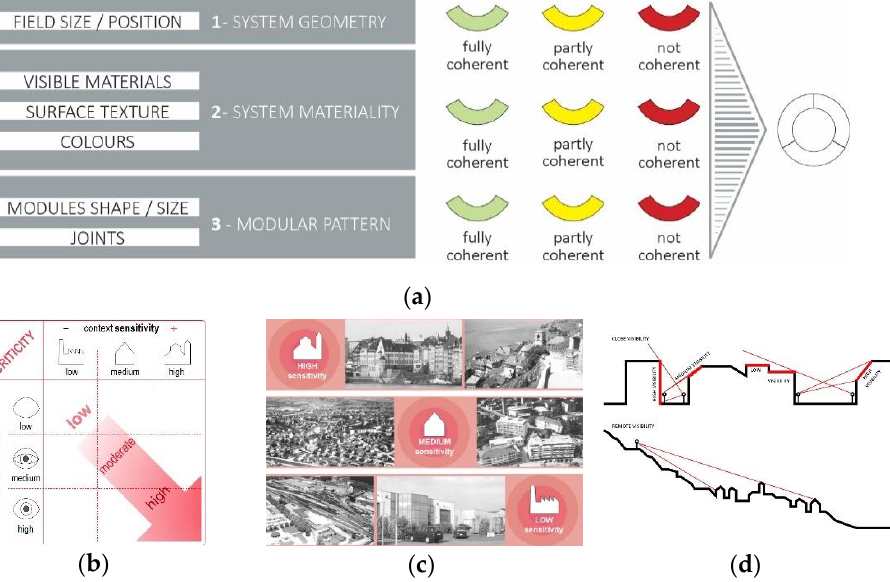
Figure 2. ( a ) Architectural integration quality matrix; ( b ) Criticality matrix developed in relation to ( c ) context sensitivity and ( d ) system visibility.